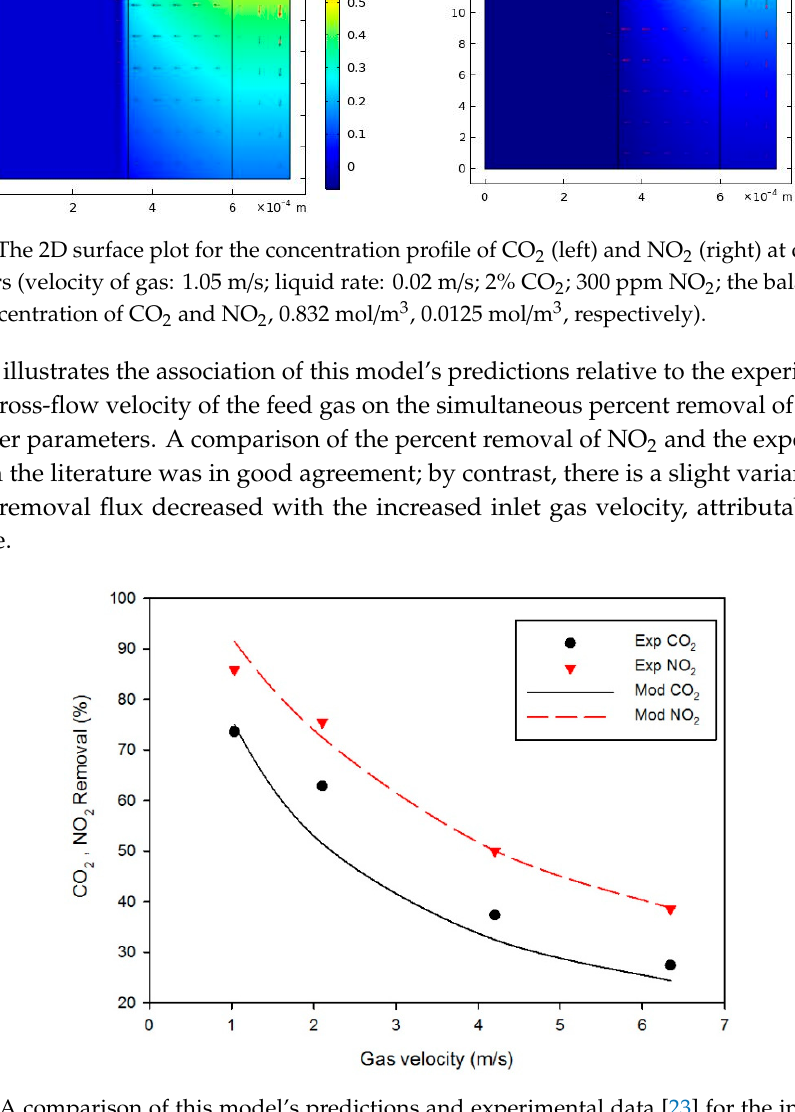
Figure 3. A comparison of this model’s predictions and experimental data [23] for the influence of the inlet gas velocity on the simultaneous percent removal of CO 2 and NO 2 (velocity of liquid: 0.05 m / s; solvent concentration: 0.5 M NaOH; inlet gas composition: 2% CO 2 ; 300 ppm NO 2 ; the balance is N 2 ).